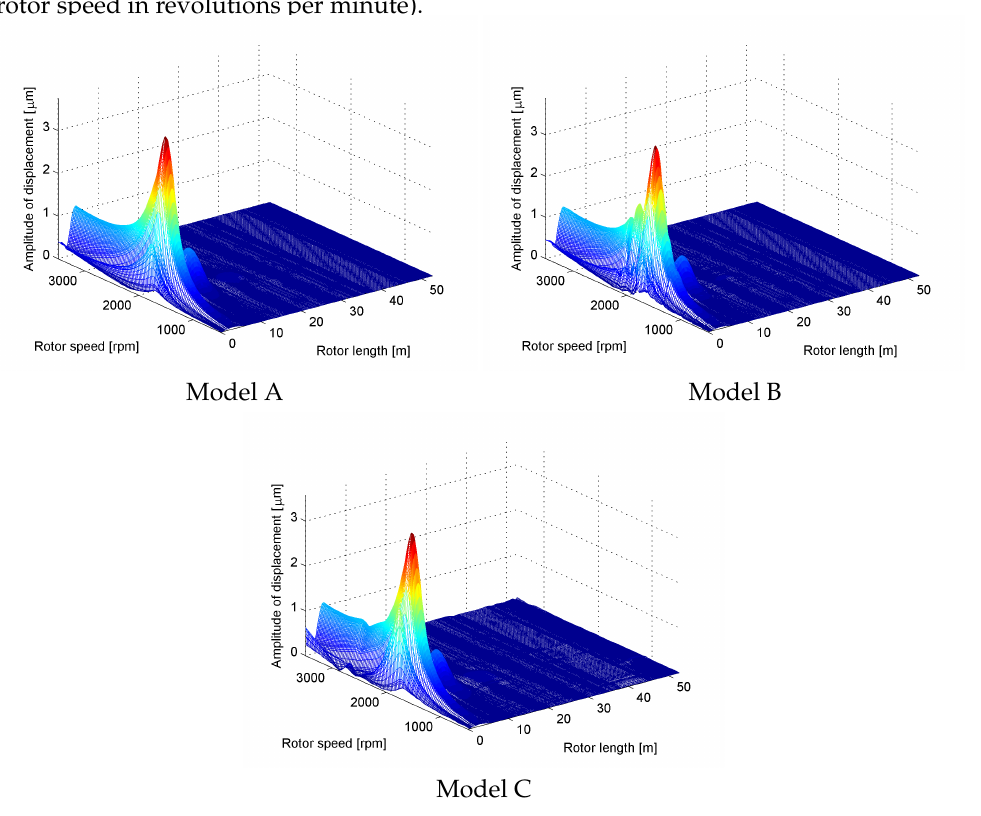
Figure 15. Absolute values of the rotor steady state complex amplitudes in the horizontal direction excited by the unbalance on the high pressure rotor